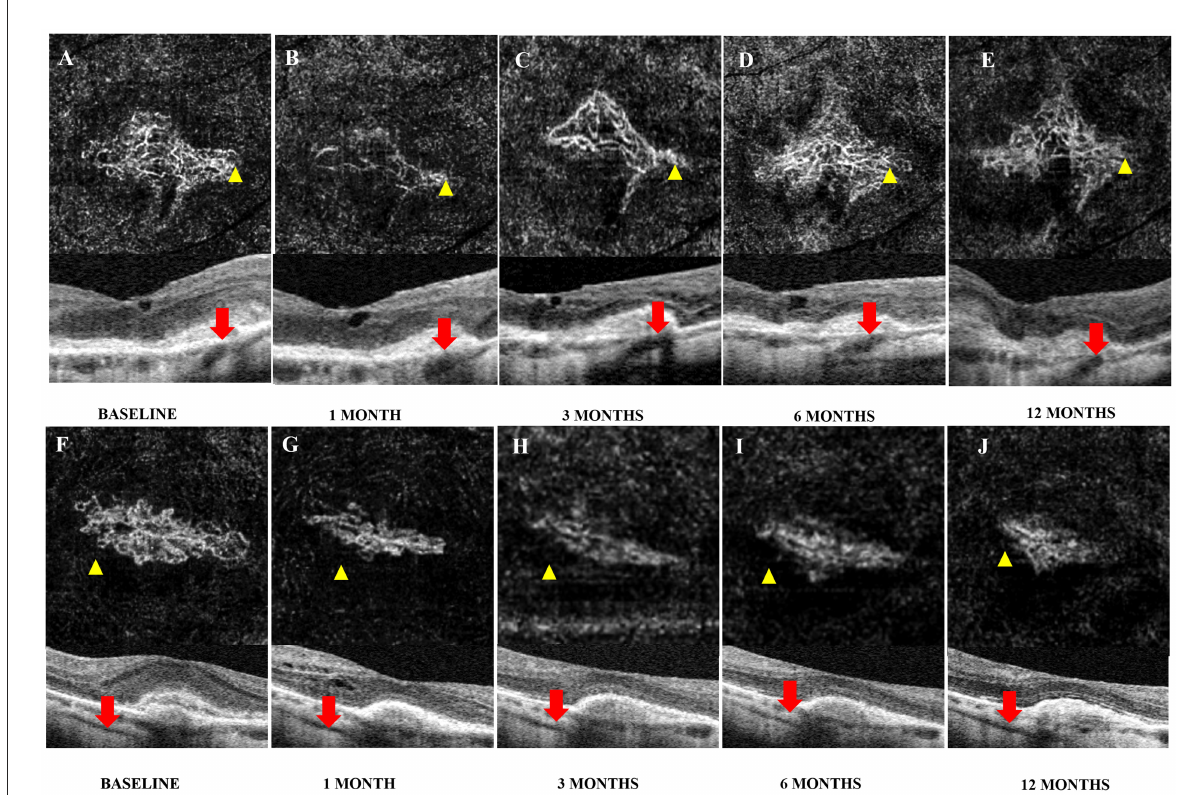
FIGURE4 Images of changes in CNV adjacent to PSVs or not by OCTA after intravitreal injection (IVI). A 64-year-old woman complained of vision loss in her right eye for 15 days. The baseline best corrected visual acuity (BCVA) was 0.80 (20/125), and the central macular thickness (CMT) was 278 µ m; she received four ranibizumab injections (initial injection, 1, 7, and 18 months after the initial treatment) during the follow-up period. (A–C) The size of both CNV and CMT decreased at 1 month after the initial injection and increased slightly at 3 months. (D) CNV recurred 6 months after the initial injection, and with an increase in the size of both CNV and CMT, one additional injection of ranibizumab was given at 7 months. (E) The size of CNV at 12 months was slightly smaller than that at 6 months. A 66-year-old woman complained of vision loss in her left eye for 10 days; BCVA at baseline was 1.00 (20/200) and CMT was 395 µ m. The patient received two conbercept injections (initial injection and 2 months after the initial treatment) during the follow-up period. (F–J) The size of both CNV and CMT decreased at 1 month after the initial injection and remained stable for the following year.